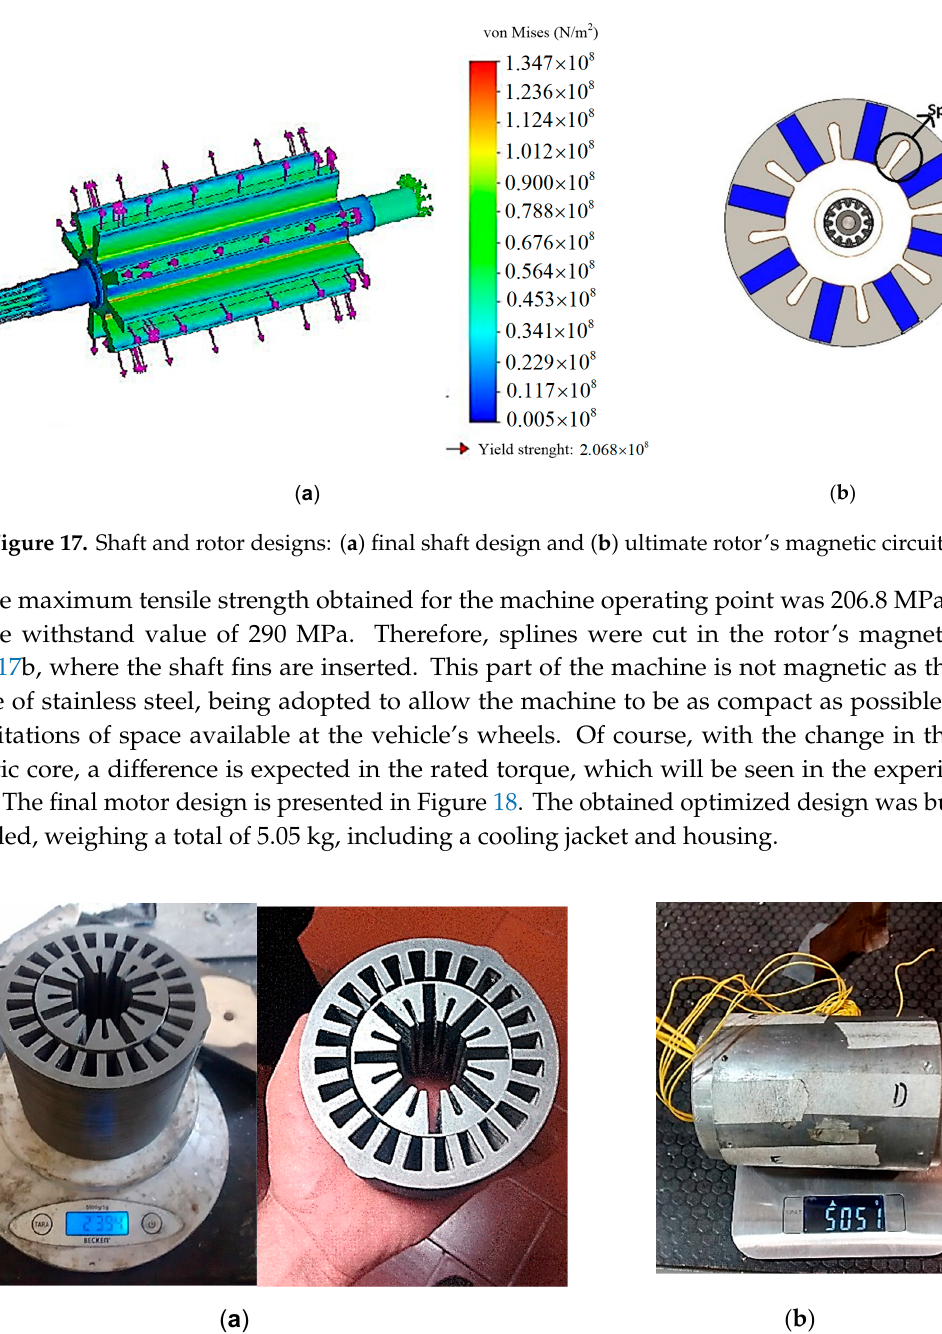
Figure 18. Final motor prototype: ( a ) magnetic circuit, ( b ) assembled prototype.